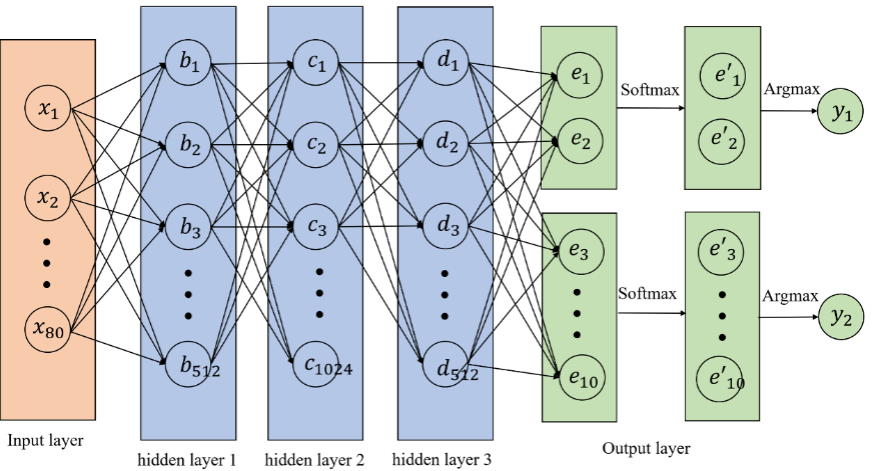
Figure 3. Neural network diagram of our ANNs model.